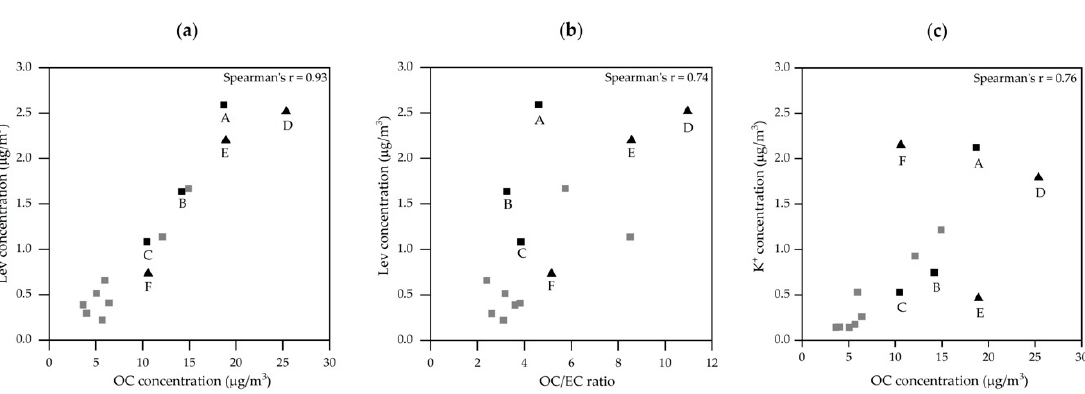
Remaining data points are shown by grey squares.